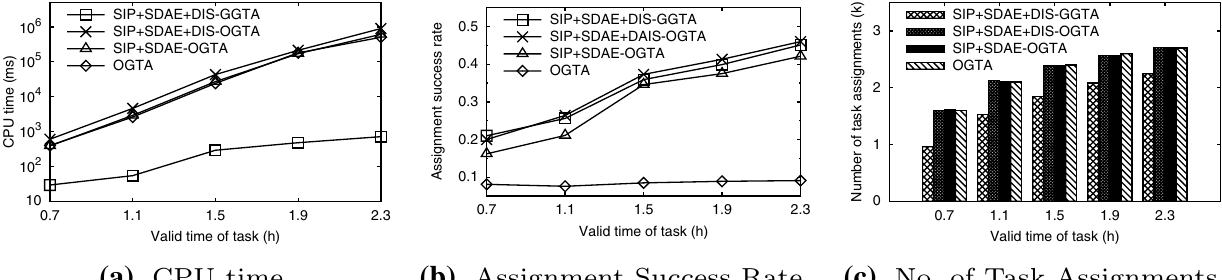
Fig. 9 Performance of group task assignment: effect of e −